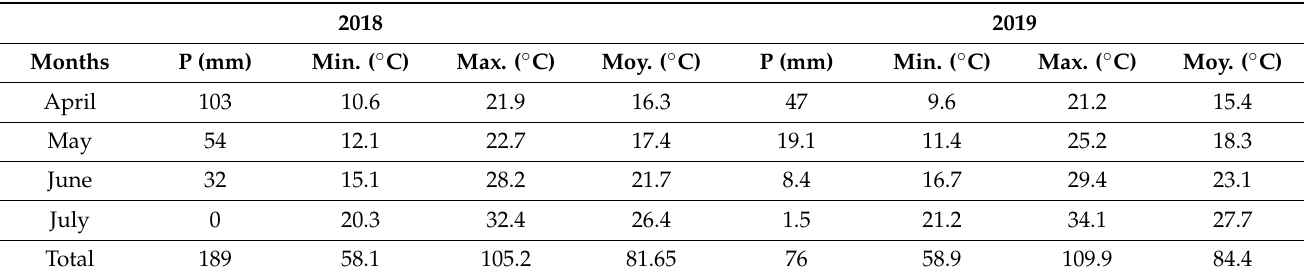
Table 1. Means of monthly temperatures and precipitations of the experimental field during the